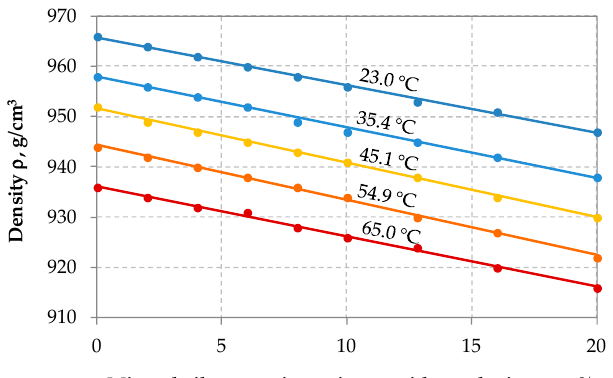
Figure 3. Density ρ of mineral oil and synthetic ester mixtures as a function of mineral oil concentration. Table 2. Values of parameters a and b , depending on temperature, for lines describing the results of density measurements of mixtures of mineral oil with synthetic ester depending on the mineral oil (MO) concentration.